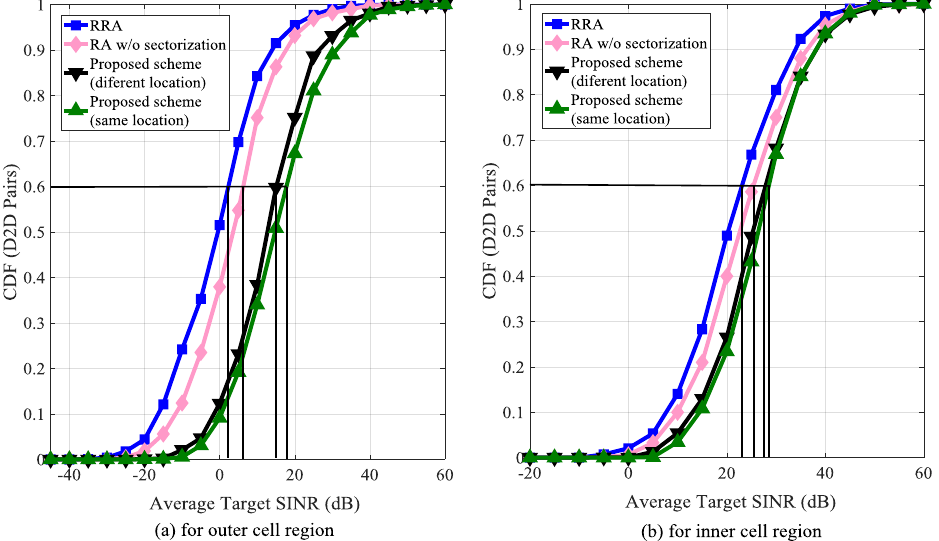
Figure 8. Average target SINR vs CDF for D2D pairs with the same and different locations of D2D Tx and Rx, ( a ) outer cell region, ( b ) inner cell region.